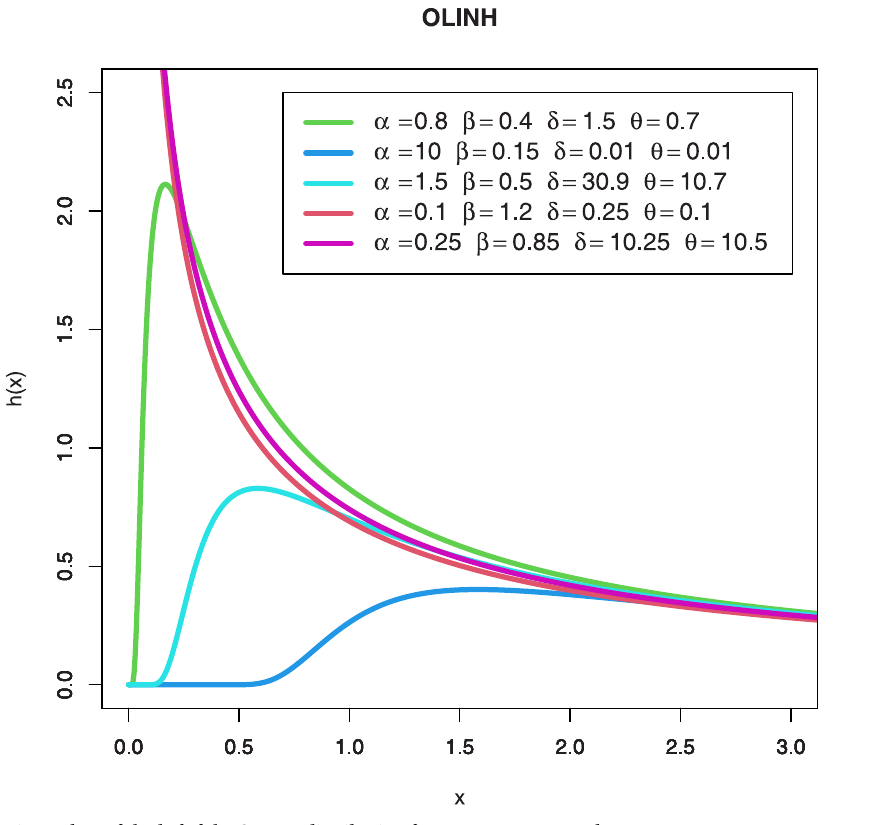
Fig 2. Plots of the hrf of the OLINH distribution for some parameter